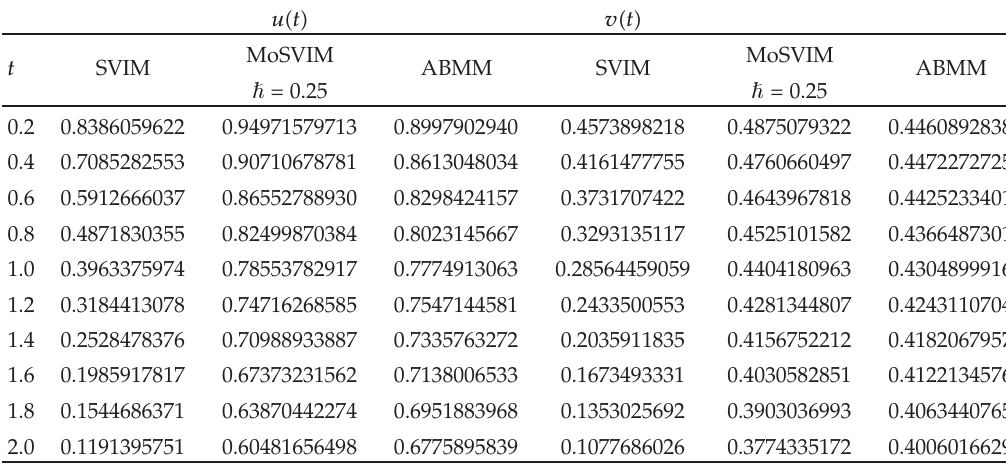
Table 1: Approximate solution of fractional biochemical reaction model for θ (cid:9) 0 . 7 , iterate of SVIM and MoSVIM, respectively, and ABMM in comparison with Δ t (cid:9) 0 . 001. u (cid:3) t